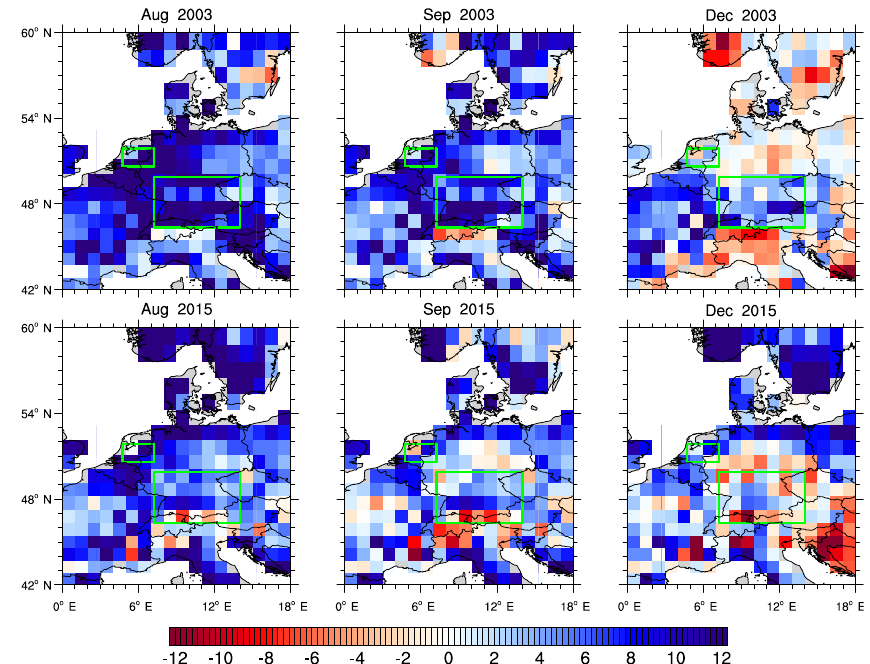
Figure A5. Groundwater anomalies (cm) based on GRACE and NOAH model outputs for the available 3 common months (August, Septem- ber, and December) during the 2003 and 2015 drought events (top panels), estimated by removing the total surface water storage anomaly (TOW, which is the combination of soil moisture, canopy storage, and snow water equivalent) from the GRACE-TWS anomaly (Fig.